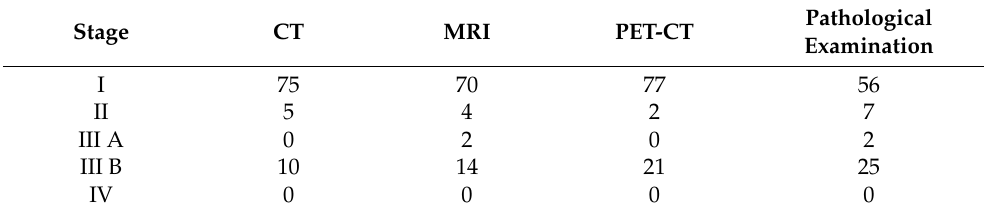
Pathological Examination